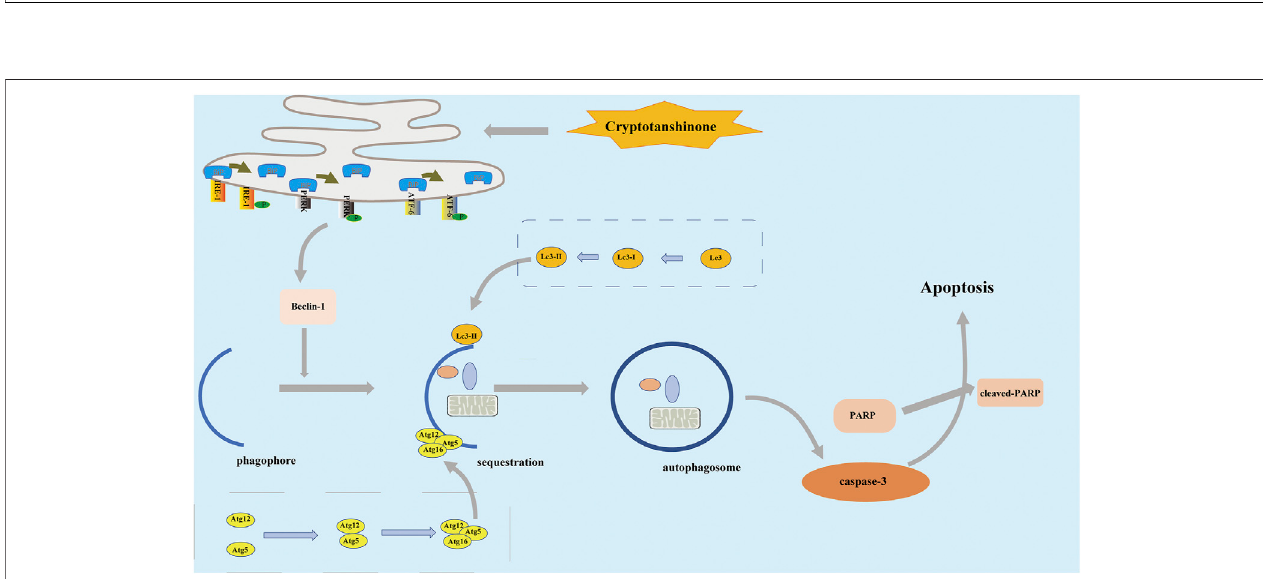
FIGURE 8 | In the treatment of HCT116 cells by CPT, the apoptosis pathway is activated, which is associated with endoplasmic reticulum stress, and autophagy. CPT, cryptotanshinone.